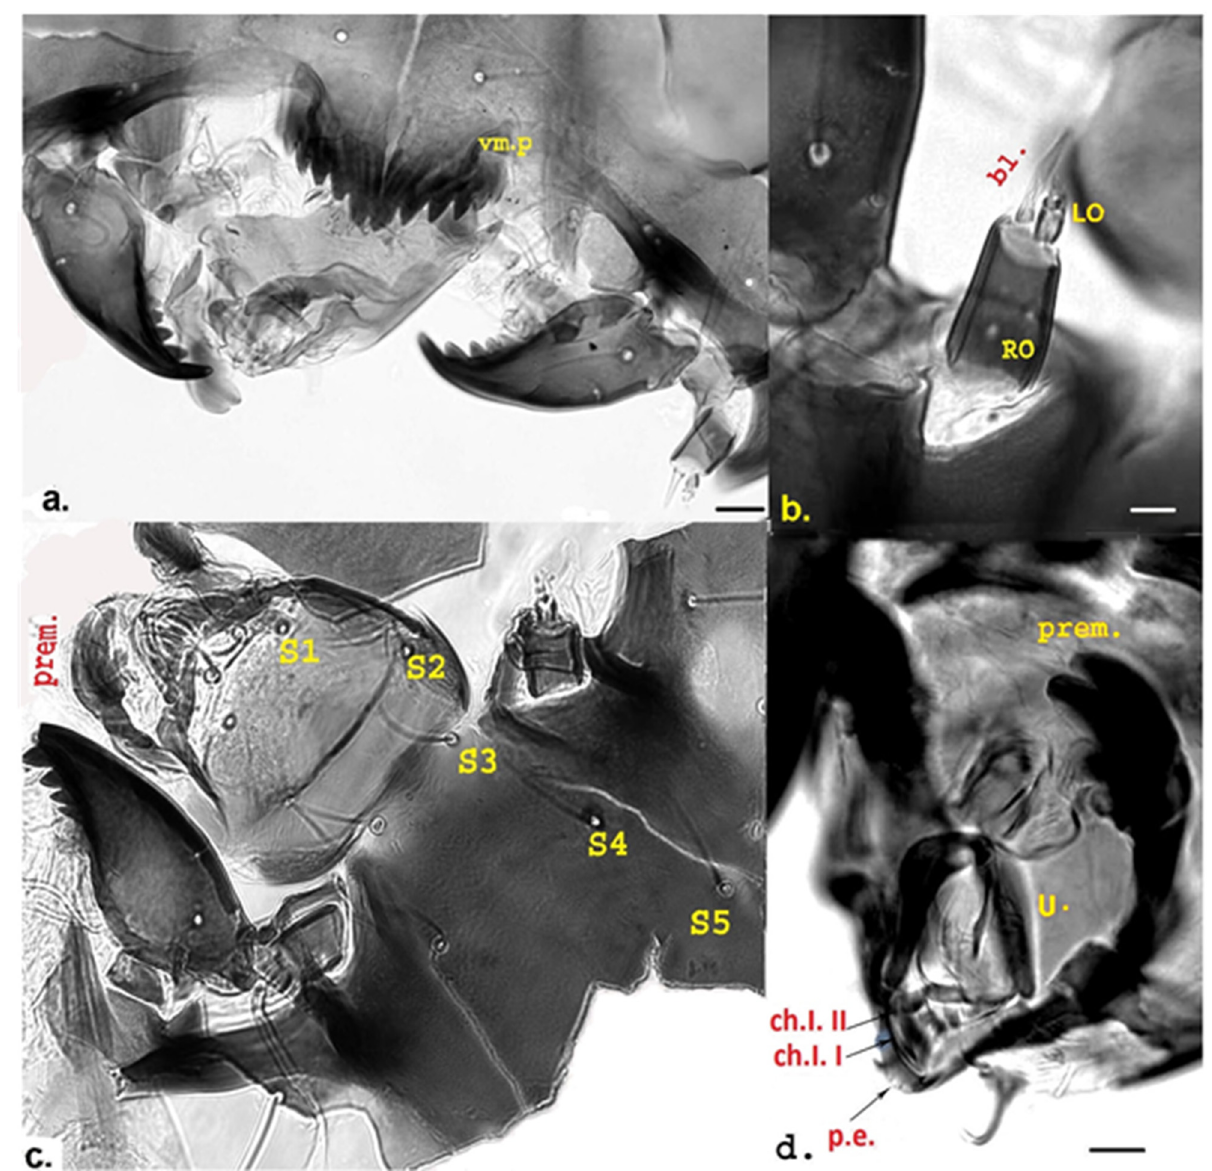
Figure 5. Larva morphology of Belgica antarctica (un-named island near Enterprise Island). ( a ) Mentum and mandibles, clearly visible ventromental plate (vm. P.); ( b ) Antenna—blade (bl.); Ring Organ (RO); Lauterborn Organ (LO); ( c ) Clypeus and frontoclypeus with setae (S1–S5), premandible (prem.) and ungula (U.); ( d ) Pecten epipharyngis (p.e); Chaetulae laterales, I-II (ch.1. I-II); premandible (prem). Scale bar 10 µm.